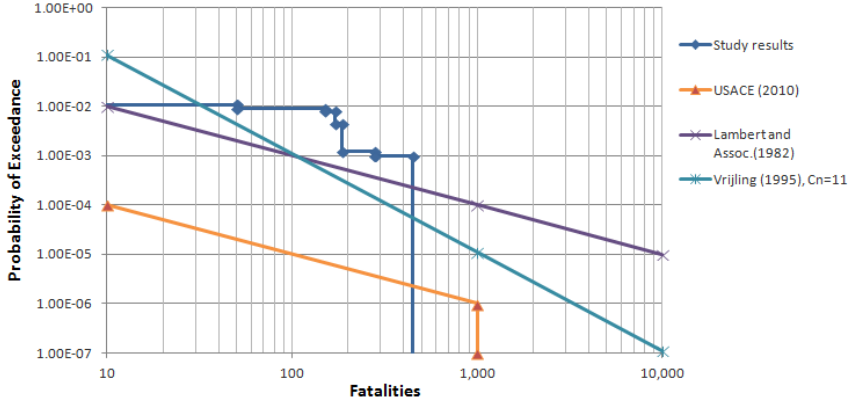
Figure 11. Societal risk estimate for the New Orleans metro bowl compared to limits proposed in literature.